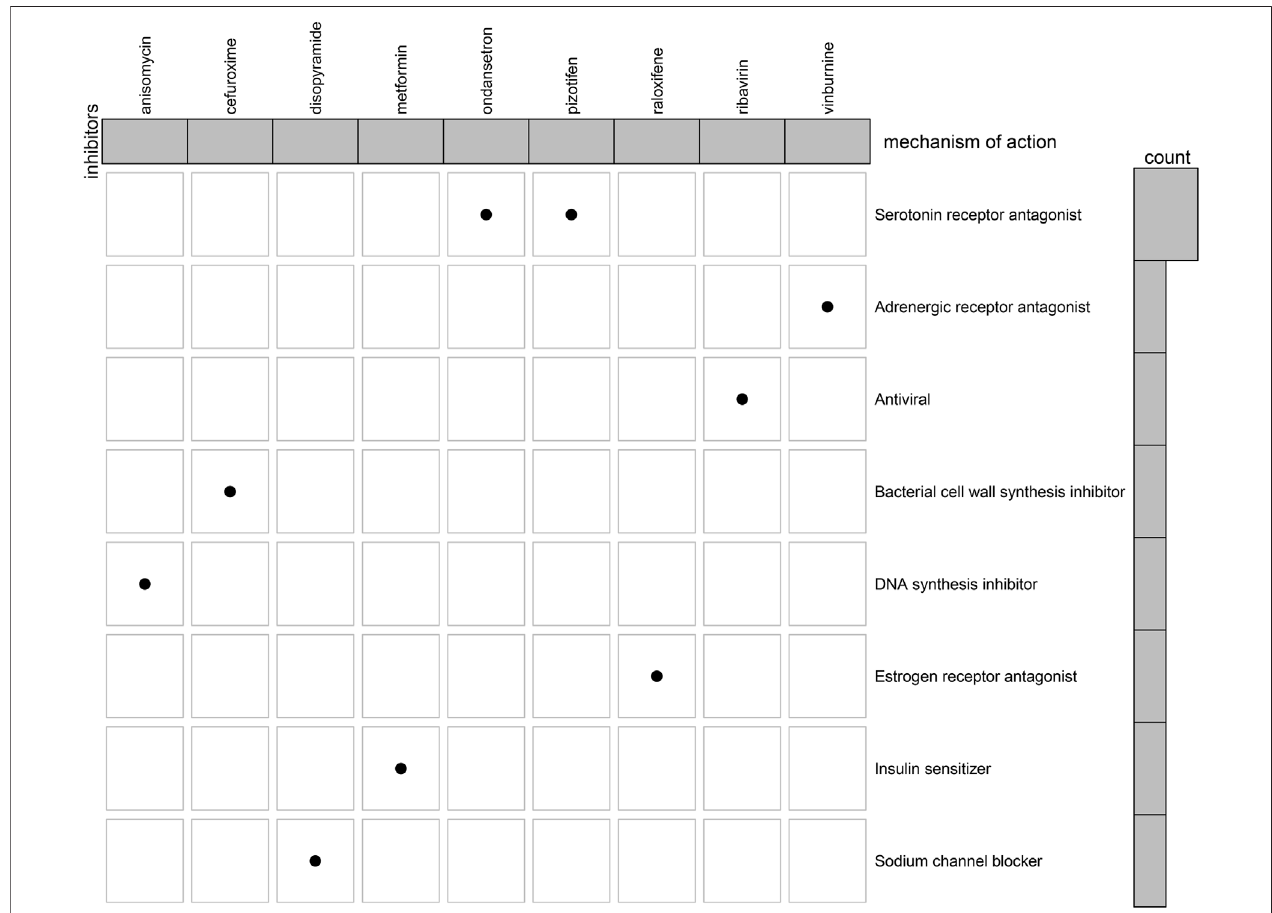
FIGURE 7 | The shared mechanisms among potential small molecule agents by Mode-of-action (MoA).